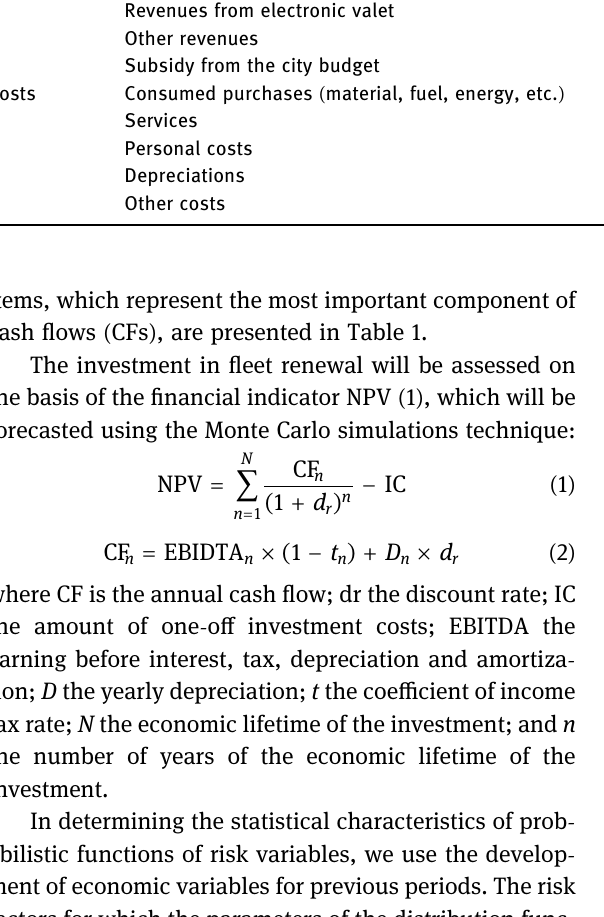
Indicator in EUR